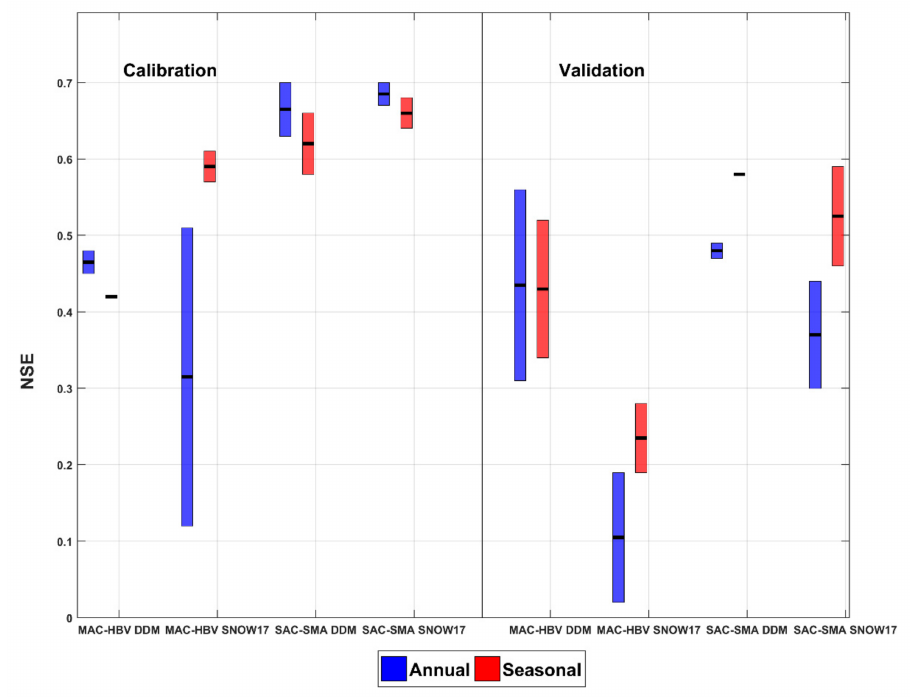
Figure 6. NSE statistics for MAC-HBV-DDM, MAC-HBV-SNOW-17, SAC-SMA-DDM, SAC-SMA- SNOW-17 model structures for annual and seasonal models of UASR. See Figure 4 for a description of the boxplots, and the median is marked with a thick black line inside